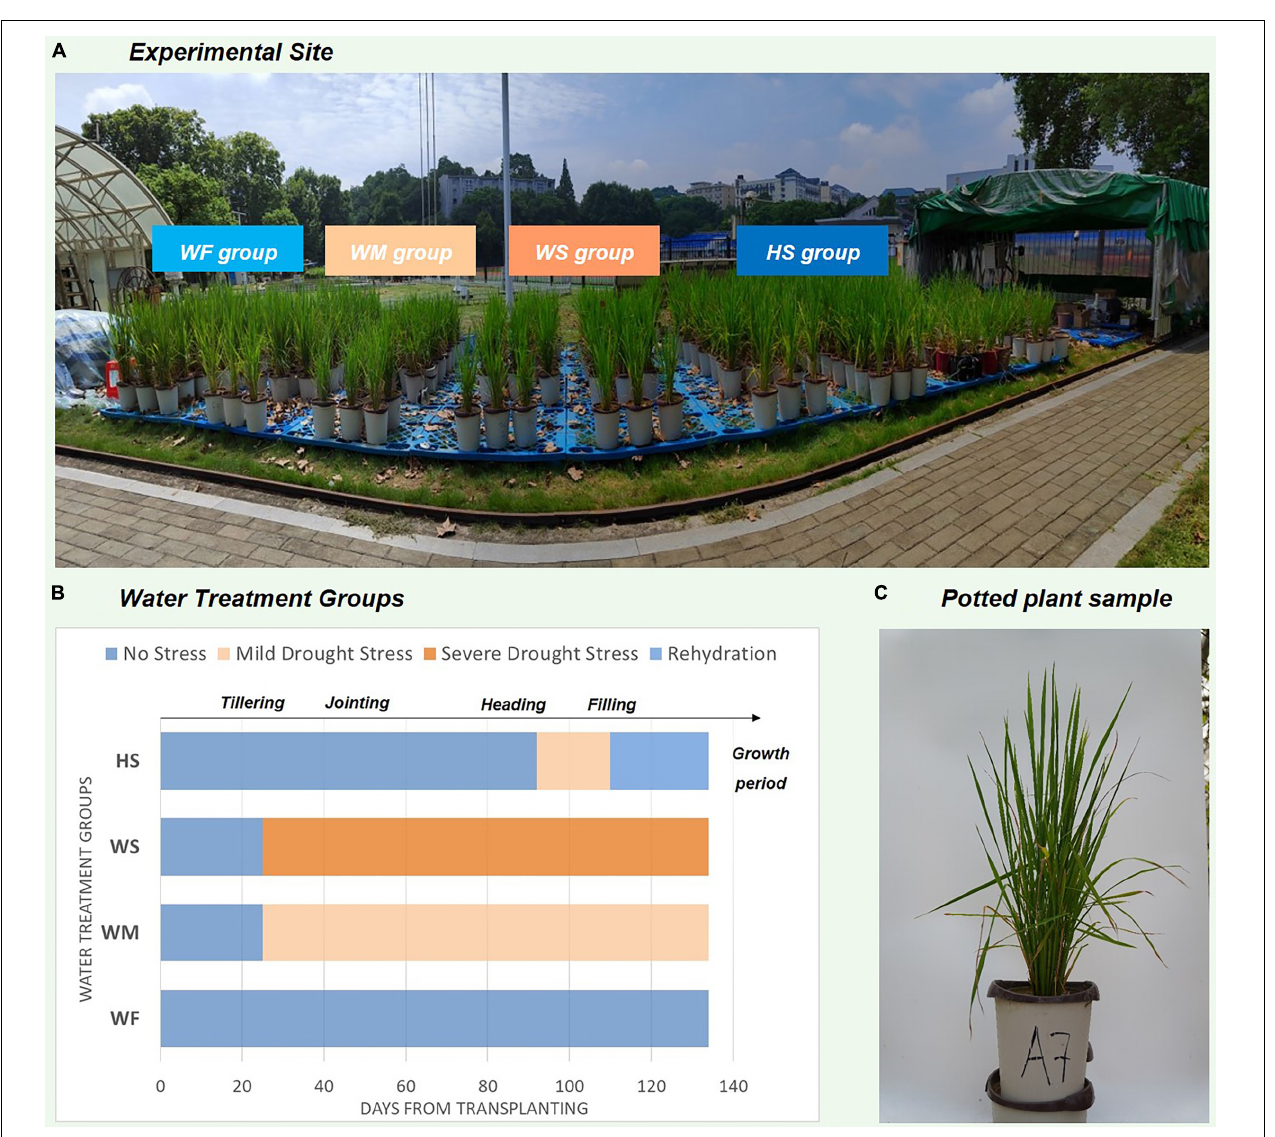
FIGURE 1 | Description of the experiment conducted and the water treatment process. (A) Experimental site, (B) The degree and duration of water stress in different water treatment groups. The x -axis number refers to time-elapsed from rice transplanting (Jun 1st), (C) Plant sample of potted